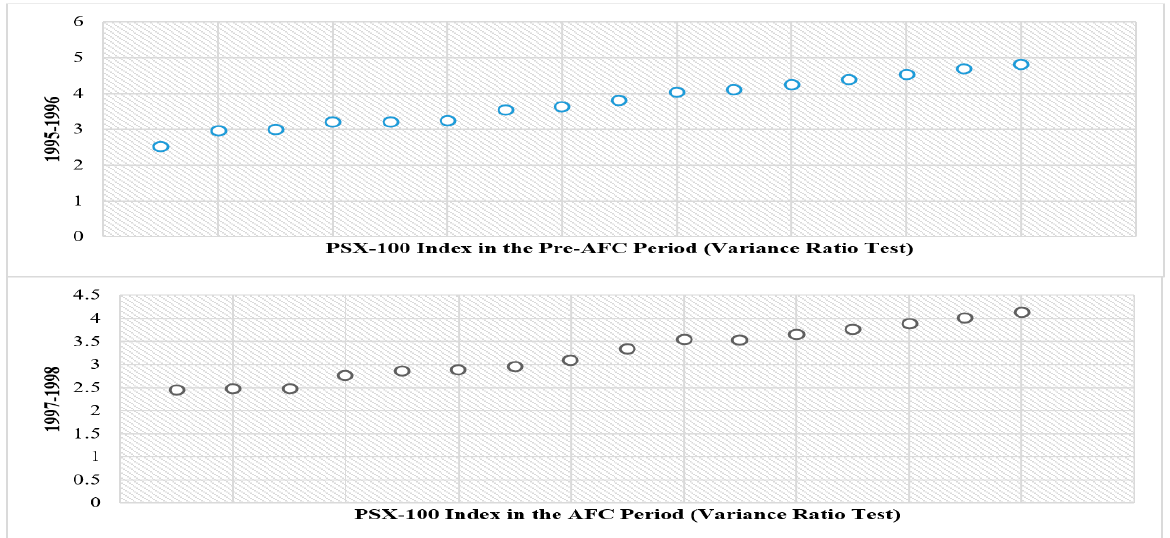
Figure 2. Informational Efficiency of PSX-100 Index in Pre-AFC (1995–1996) and AFC period (1997–1998). 3